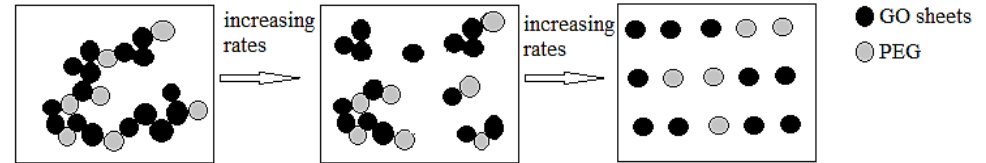
Figure 13. Schematic representation of the breakdown of the structure into flocs with increasing shear rates.